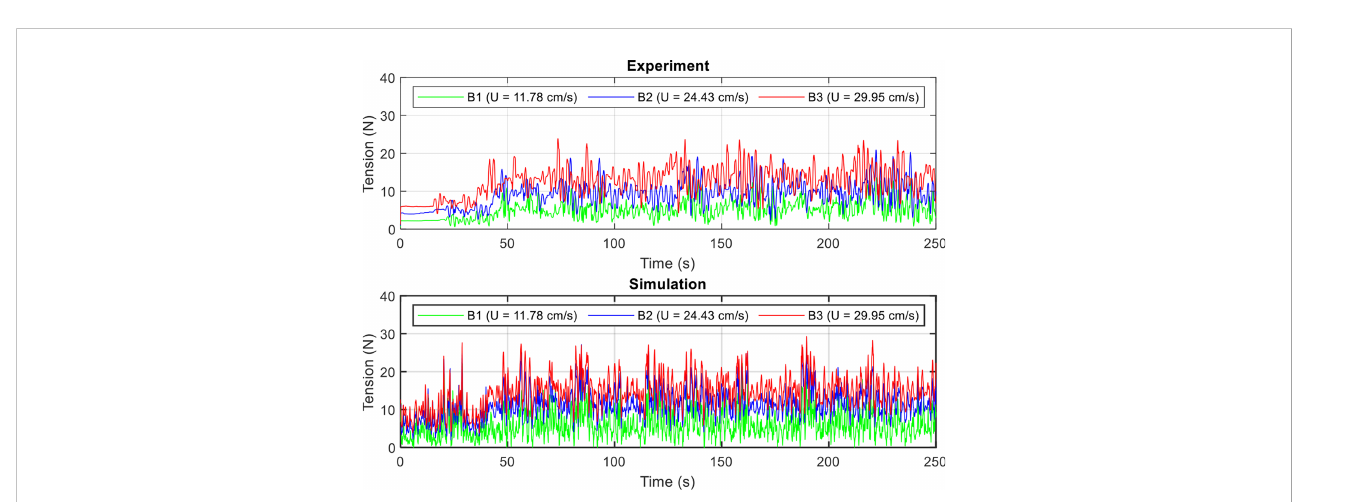
FIGURE 12 In fl uence of the current velocity on the time series mooring force under the mooring line failure of a net cage in irregular waves and currents.